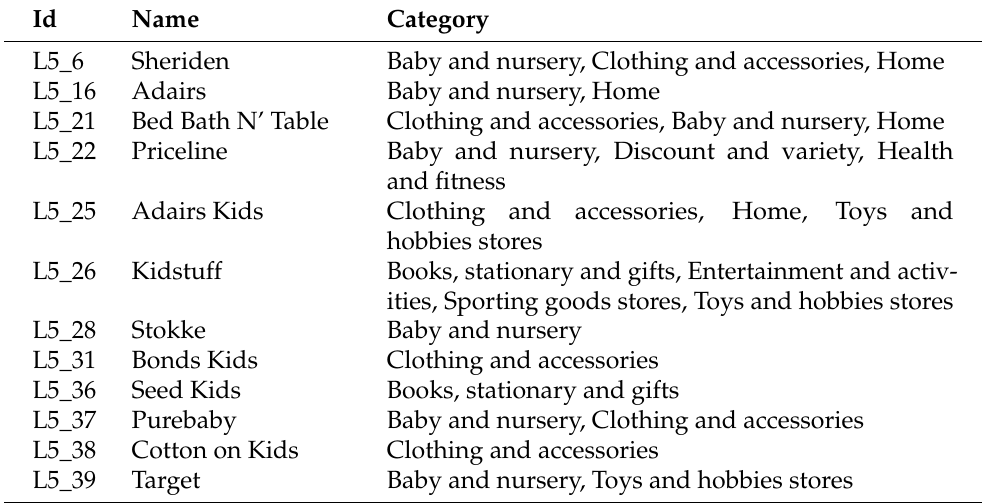
Table 4. The twelve shops with products for babies or kids.